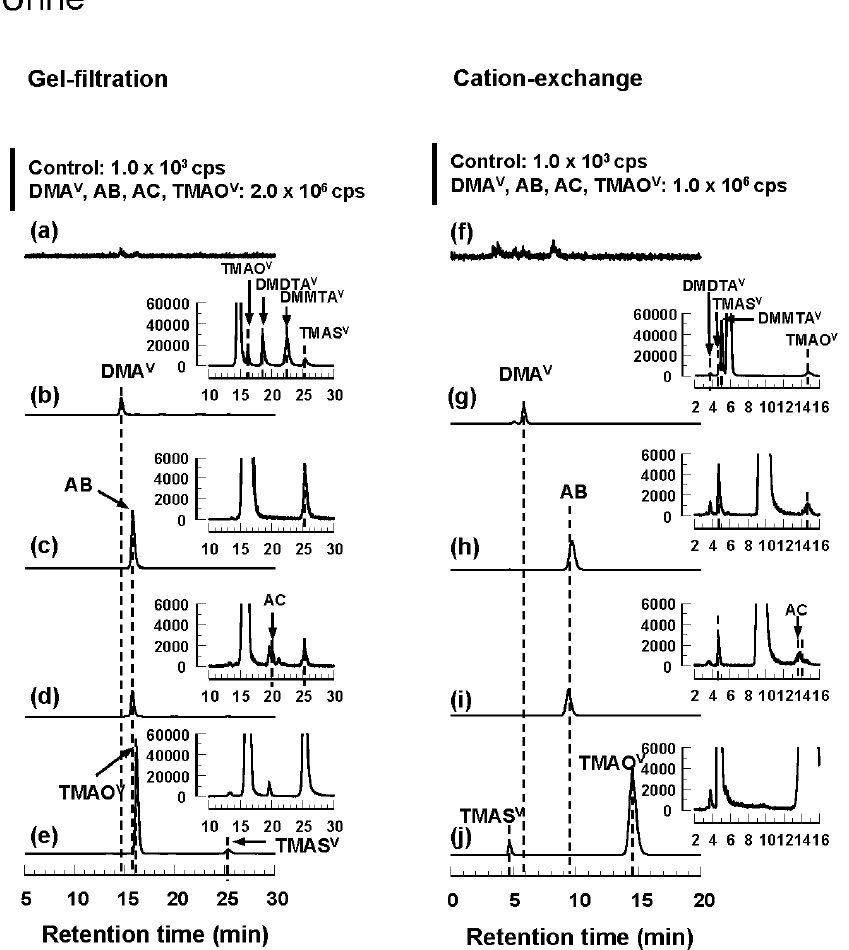
Figure 5. Elution profiles of 0–24-h urine in rats after oral administration of: ( a , f ) deionized-distilled water (control); ( b , g ) DMAV; ( c , h ) AB; ( d , j ) AC; or ( e , j ) TMAOV. Samples were separated by ( a – e ) gel filtration or ( f – j ) cation-exchange and assayed by HPLC-ICP-MS. A 20- µ L sample was applied to the columns, which were eluted with the pre-filtered (0.22 µ m) mobile phase (see Table 1 for the elution conditions). The vertical bars indicate the level of detection (counts per second, cps) for the main panels; separate scales (in cps) are provided for the insets.